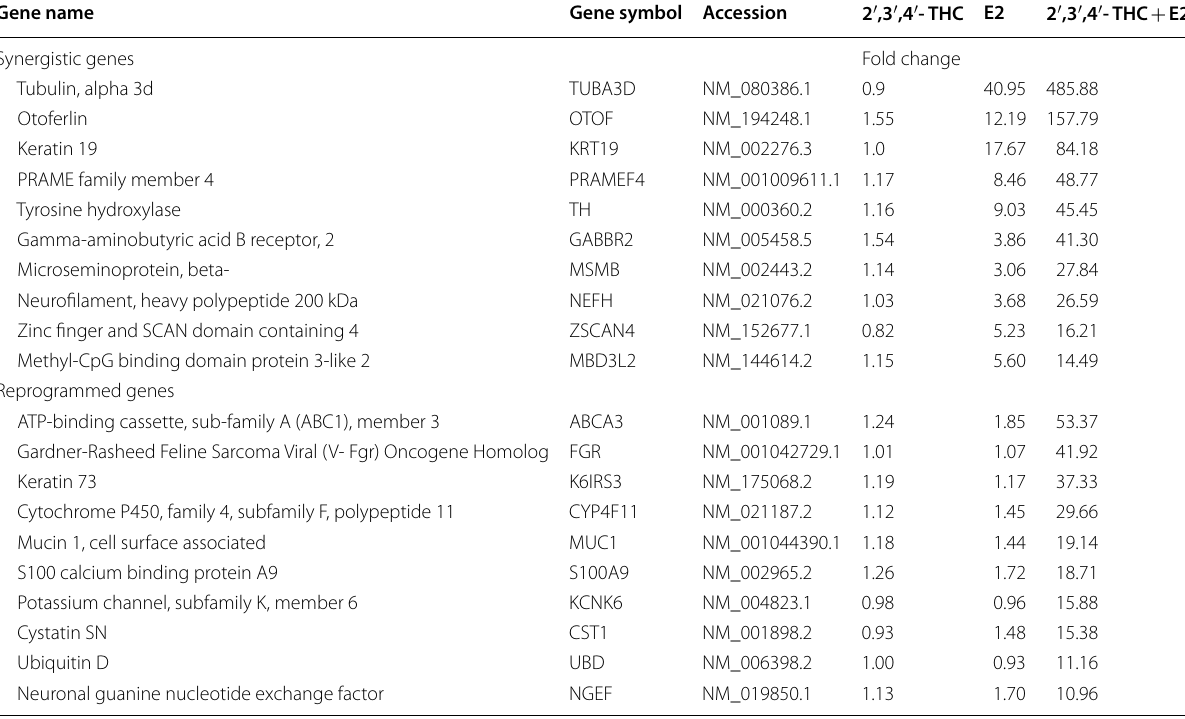
Table 1 Representative examples of the synergistic and reprogrammed genes regulated by the 2 ′ ,3 ′ ,4 ′ ‑THC/E2 combination from the U2OS‑ERα